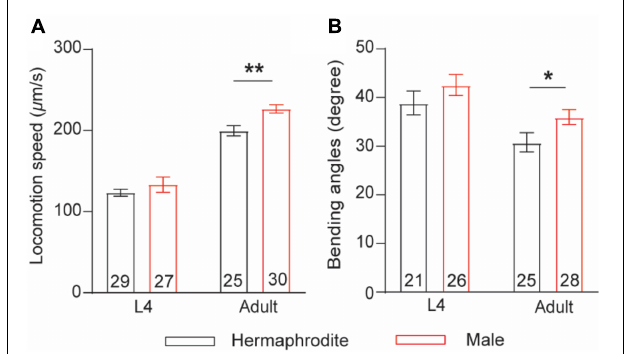
FIGURE 1 | Adult C. elegans exhibits sex-specific difference in locomotion behaviors. (A) Bar graph of the locomotion speed of hermaphrodites and males at the larval stage L4 and adult stage (** p = 0.0015, t -test). (B) Bar graph of the bending angle of hermaphrodites and males in the larval stage L4 and adult stag (* p = 0.0416, t -test). Sample sizes ( n numbers) are indicated in the bars of each graph. All data are represented as mean ±